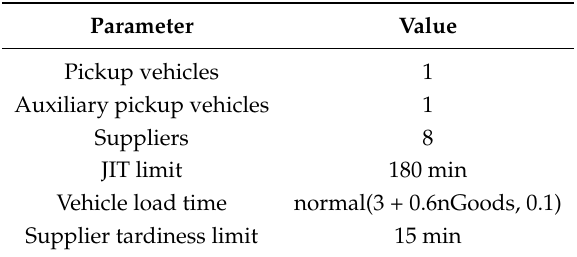
Table 5. Solution